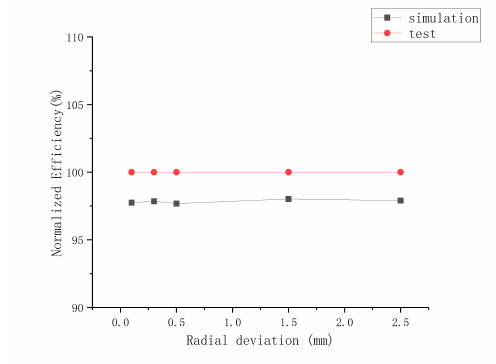
Figure 5. Simulation and experimental efficiency